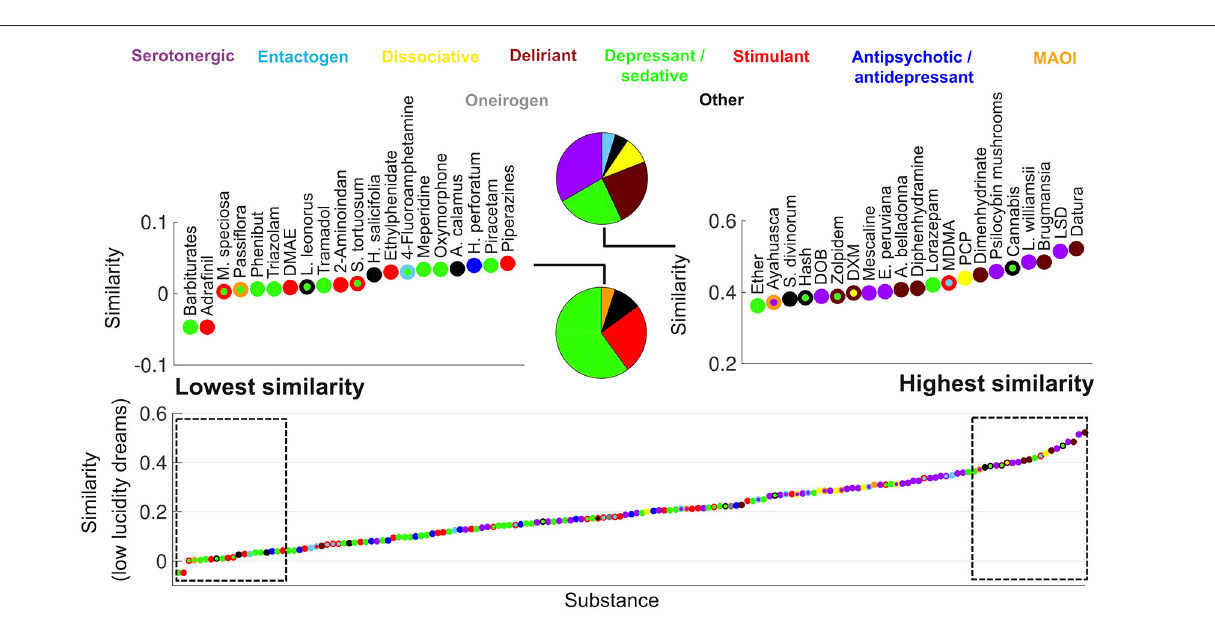
FIGURE 2 | Ranking of psychoactive substances in the Erowid corpus in terms of the similarity of their subjective reports to those of low lucidity dreams (Dreamjournal corpus). The rectangles on the left/right zoom into the top 20 lowest/highest ranking substances and the pie charts indicate the proportion of each primary category. Substances are represented with circles that are color-coded based as in Figure 1